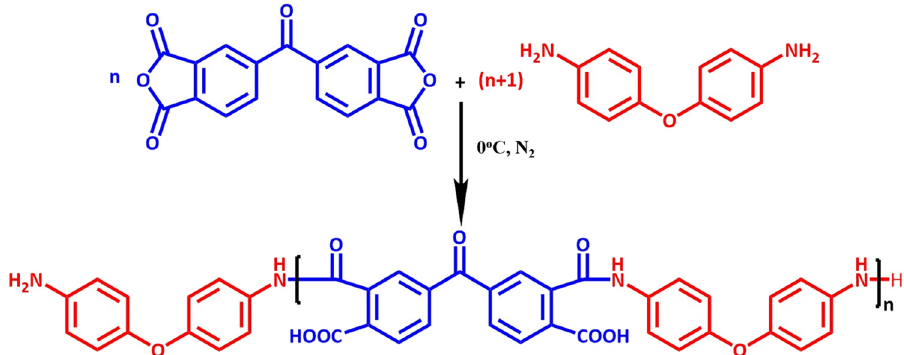
Figure 2: The reaction equation between BTDA and ODA.